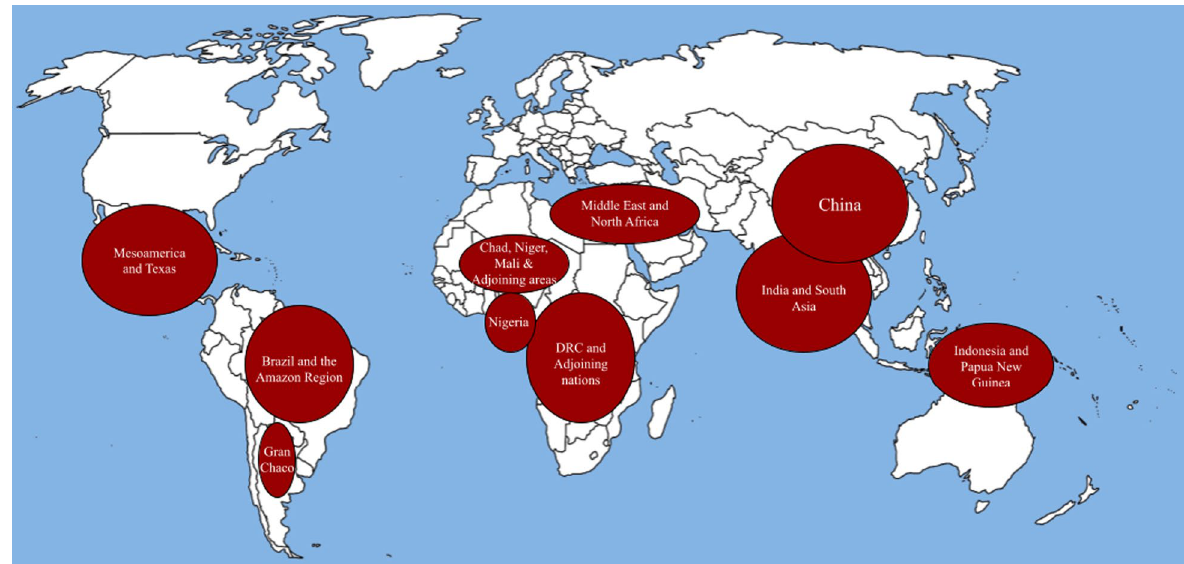
Fig. 1 The 10 global hotspots for neglected tropical diseases